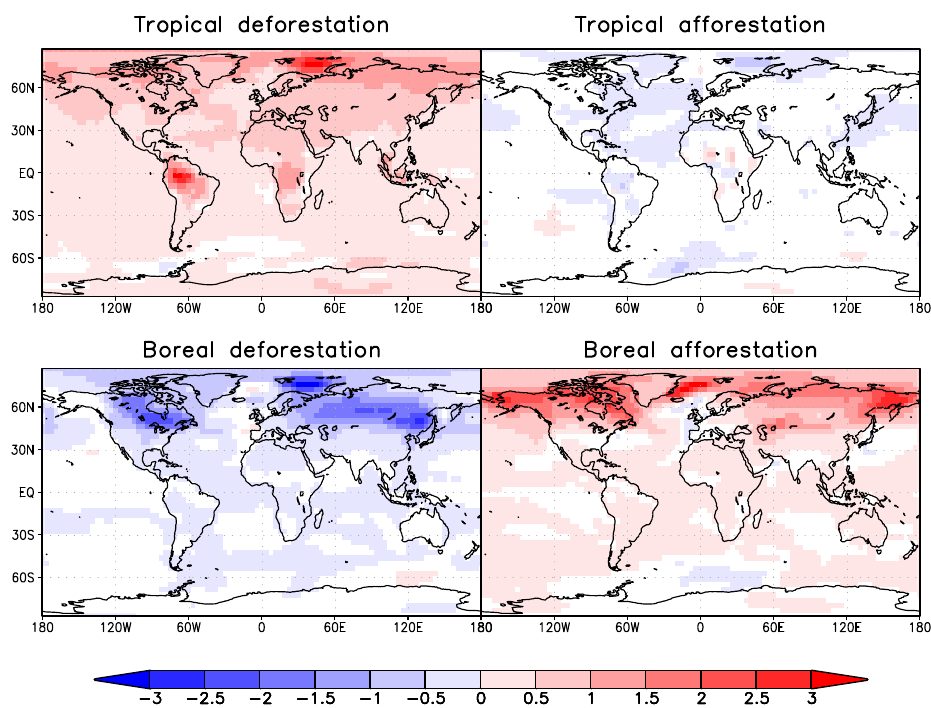
Fig. 3. Anomalies in 2m-temperature averaged over the final 200years for each experiment. White areas show no significant changes according to a t-test with 95%